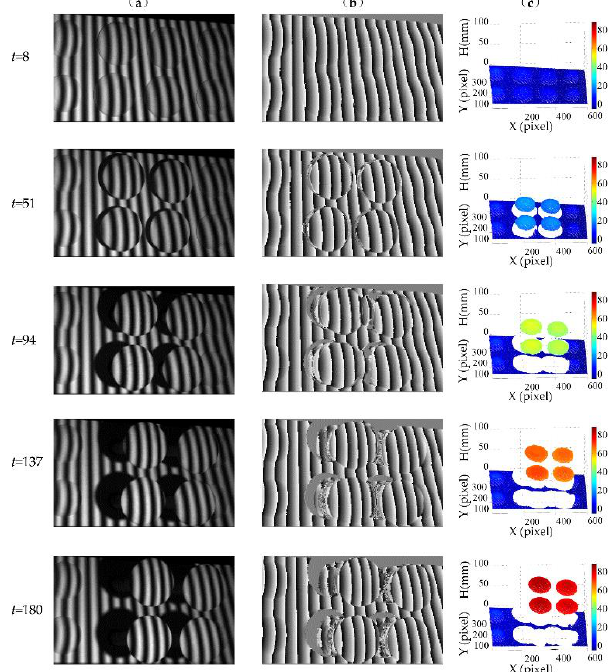
Figure 14. Experimental results of a moving wooden model. ( a ) Deformed fringe patterns, ( b ) wrapped phase distribution and ( c ) 3D reconstruction of 5 different moments.